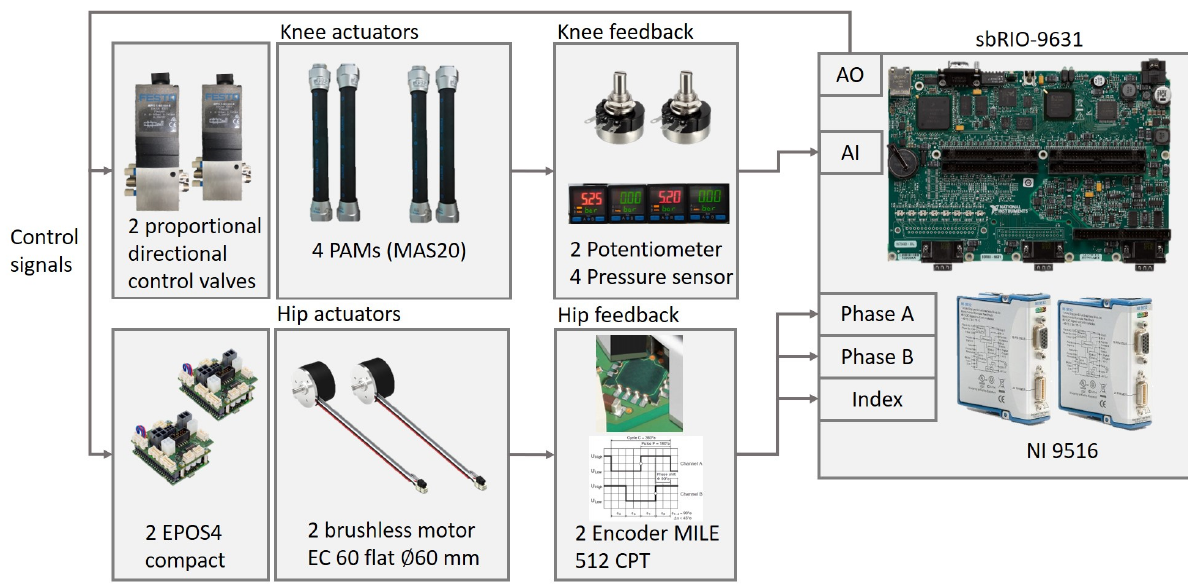
Figure 7. Block diagram of the powered lower limb exoskeleton robot. Table 1. Specification list of hardware and equipment for the proposed LLRES.